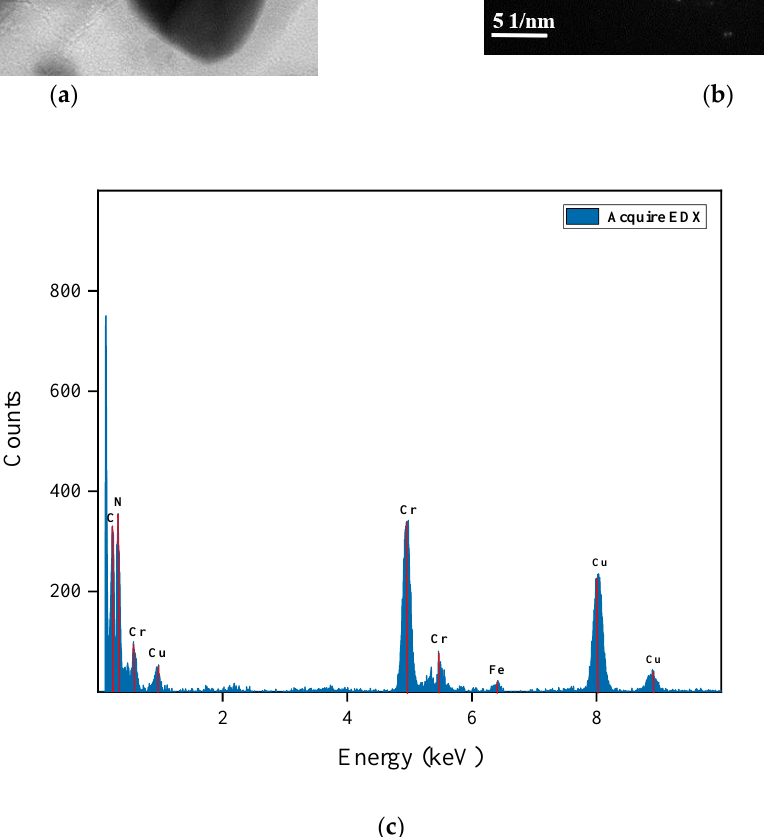
Figure 8. ( a ) TEM image of inclusion; ( b ) Diffraction pattern of inclusion; ( c ) EDS results of inclusion; Number 5 represents the fifth point for EDS scanning; The outer region surrounded by yellow line is Cr 7 C 3 , and inner region surrounded by red line is Al 2 O 3 .